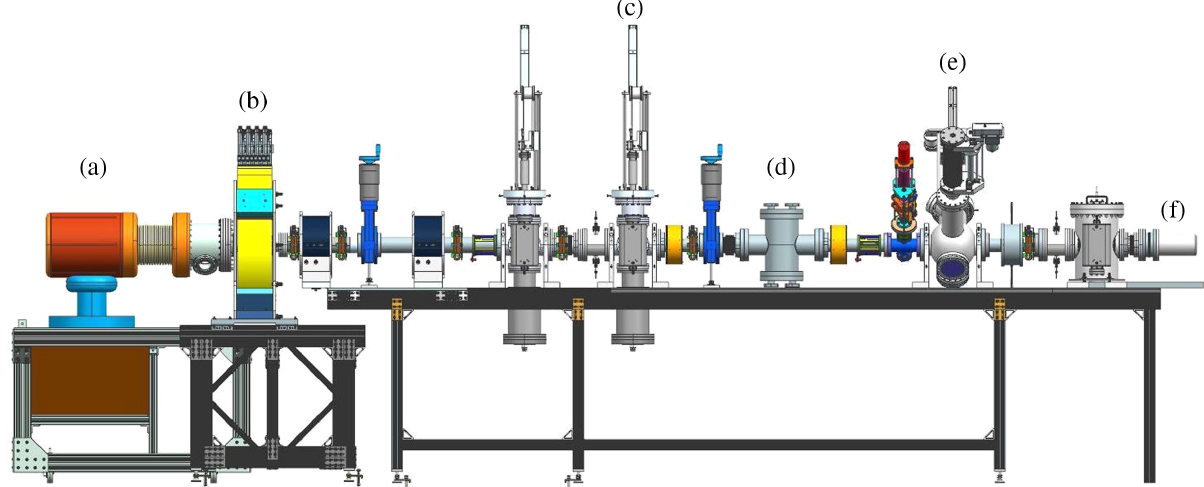
device.FIG. 1. Mechanical model of the test beamline (a) thermionic gun (b) mgnetizing solenoid (c) housing for 1D pepper-pot (d) deflecting cavity (e) housing for viewer screen (f) beam